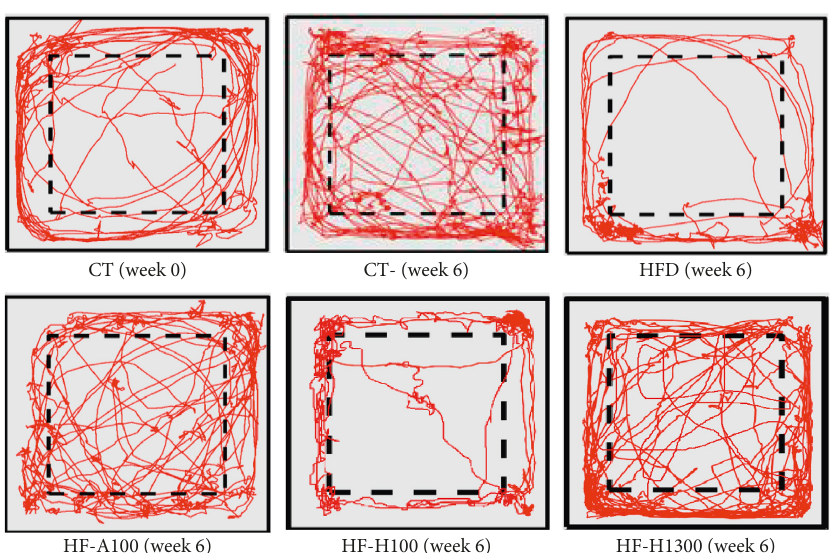
Figure 9: Representative trajectories of test mice. Note: CT-T0 and CT-T6 are CTgroups at week 0 and week 6. The peripheral region is the space between solid and dashed lines. The central area is the space inside the dashed